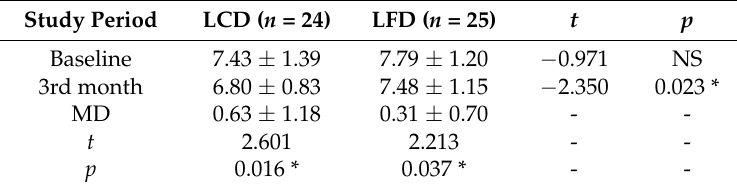
Table 4. Comparison of glycated hemoglobin (%) between the two groups.